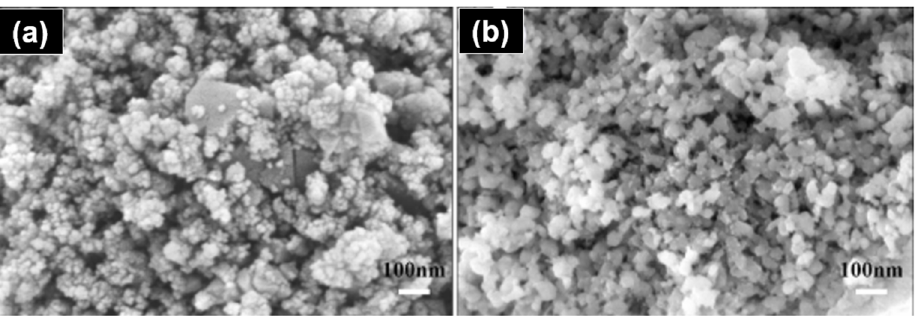
Figure 9. SEM image of the catalyst after the anti-sulfur reaction: ( a ) MF and ( b ) Ce 0.2 -MF.